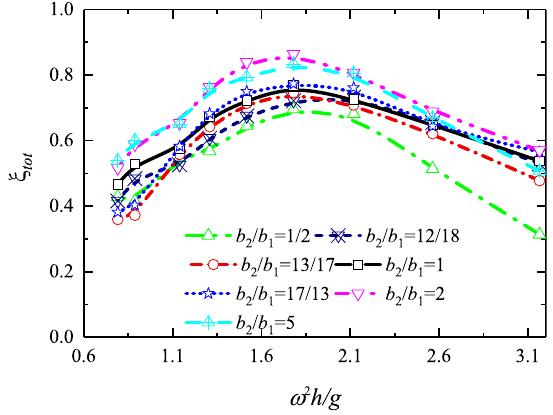
Figure 12. Total wave energy extraction efficiency by front and rear